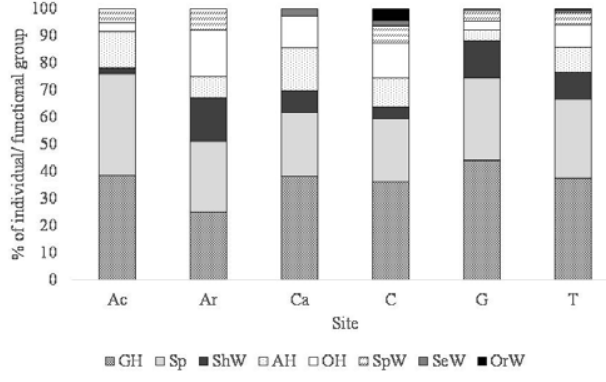
Fig 4. Percentage of spiders per functional group. Ac – Aciprestes;